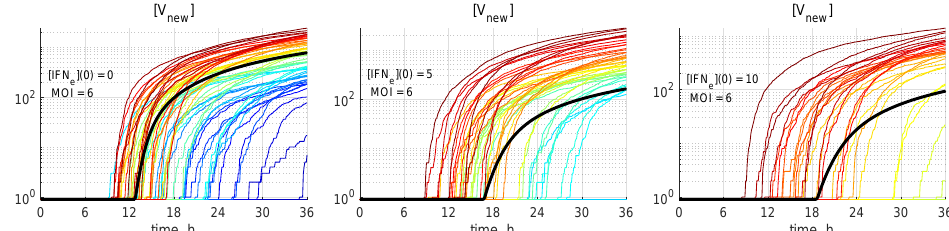
Figure 5. The number of all new virions produced and released by an infected cell in relation to the abundance of external IFN. Stochastic trajectories for [V new ] ( t ) and different values of initial intercel- lular IFN, indicated in every plot. The bold black line represents the corresponding deterministic trajectory. The larger the released progeny, the closer is the colour to the red end of the spectrum, and vice versa, the lower the output, the closer is the colour towards the blue end of the